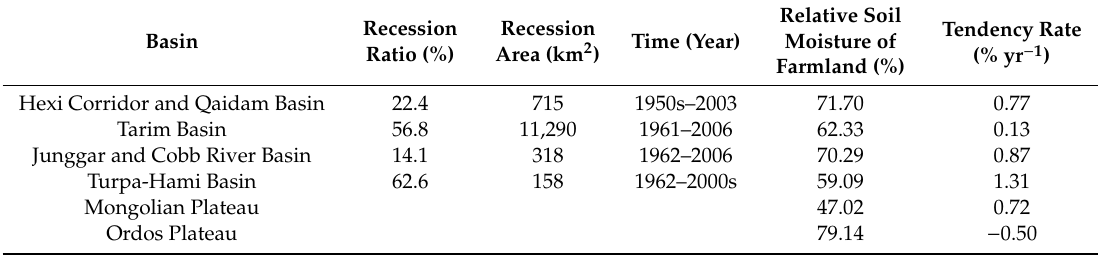
Table 4. Changes to glaciers and the relative soil moisture of farmland in inland river